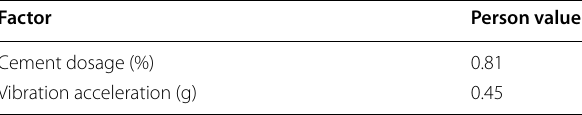
Table 5 Person value between the 7-day UCS and cement dosage and vibration acceleration. Factor Person value Cement dosage (%) Vibration acceleration